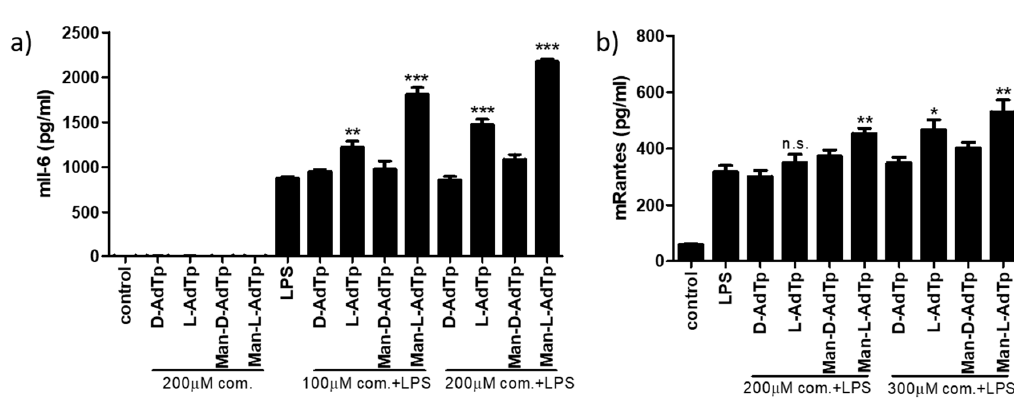
Figure 3. PGN derivates promote LPS signaling detected on the cytokine protein level. PGN derivatives (100 µ M and 200 µ M for Il-6 and 200 µ M and 300 µ M for RANTES) were incubated or preincubated with iBMDMs and then stimulated with LPS for 16 h; for Il-6 ( a ) with 5 ng / mL LPS and for RANTES ( b ) with 1 ng / mL LPS. ELISA assay was performed. Statistics: Student’s t -Test * p < 0.05, ** p < 0.01, *** p < 0.001. As control unstimulated cells were used. Representative experiments from 2 independent experiments are